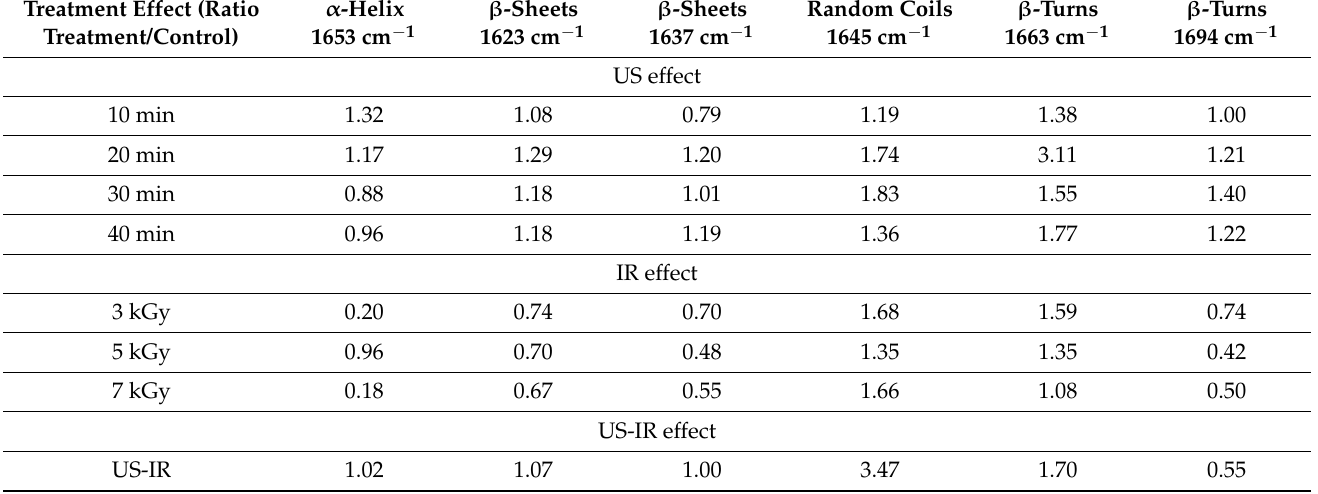
Figure 3. FTIR spectra of cricket proteins before treatments (control), after ultrasound (US) treatment (10, 20, 30 and 40 min) ( a ), γ -irradiation (IR) treatment (3, 5 and 7 kGy) ( b ), and after single and combined treatments US, IR and IR assisted with US (US-IR) ( c ). For each global spectrum, focused areas in the regions 3500 – 3300 cm − 1 and 1628 – 1200 cm − 1 indicate the main vibration changes related to the secondary structure of proteins. Table 1. Effect of ultrasound treatment on the secondary structure of cricket protein. Data were collected from the amplitude of negative bands of second derivative spectra in the Amide I region (1700–1600 cm − 1 ) and the ratio of treatment/control was